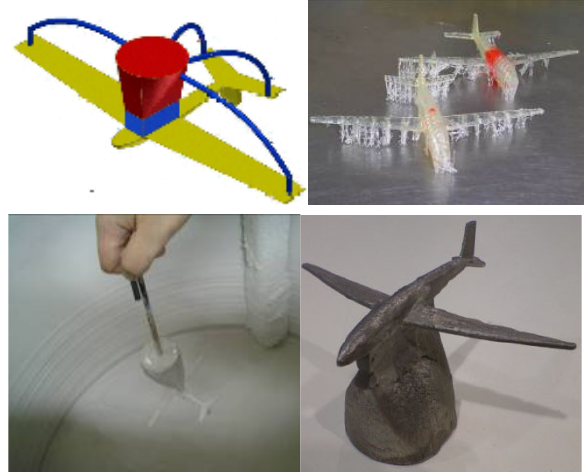
Figure 6. Metallic airplane for tests in a wind tunnel; CAD model, quick cast model, ceramic shell manufacturing and metallic casted part.